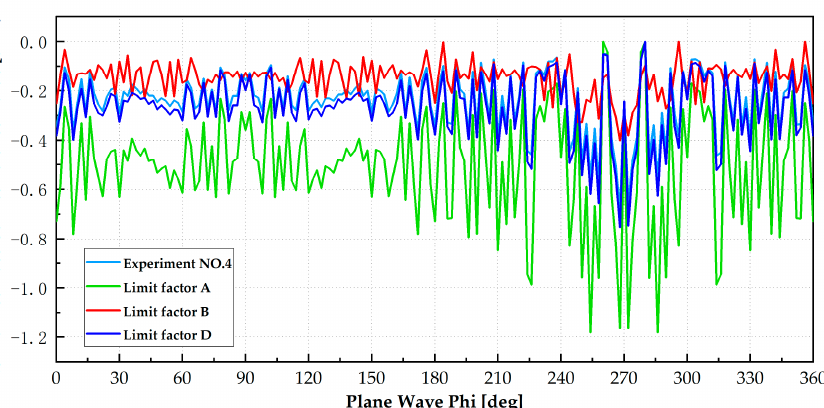
Figure 11. Comparison of passive interference results of experimental model No. 4 and its limiting factors A, B, and D.